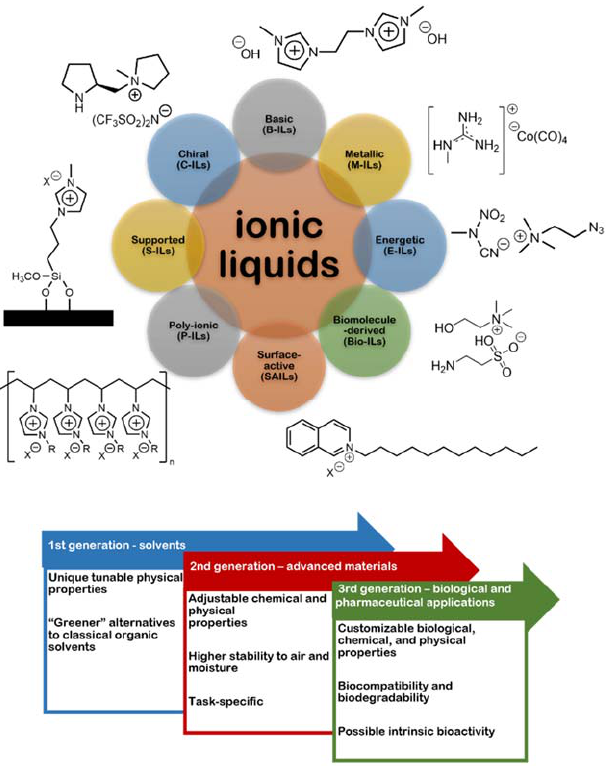
Figure 9. A few examples of different types of ILs, and their three recognized generations.